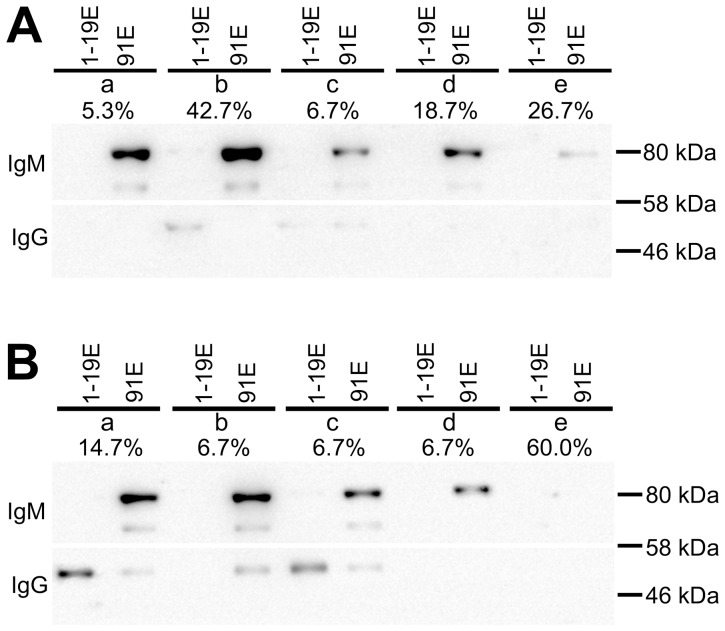
Western blot for IgG and IgM eluted from H31
–19 and H31–19K9me beads.Equal volumes (1.5 ml) of pooled sera were first absorbed with the H31–19 beads and then with the H31–19K9me beads as described in the Materials and Methods. The beads were washed 5 times with 1 M NaCl, and the bound Abs were eluted with 50 µl elution buffer. 10 µl of the eluates underwent SDS-PAGE under reducing conditions and were then transferred onto nitrocellulose membranes. The membranes were cut at the 58 kDa position. IgG on the low molecular weight (<58 kDa) membrane and IgM on the high molecular weight (>58 kDa) membrane were detected. (A) Healthy adult samples; (B) aSLE patient samples. a, IgG(1–19high91x)IgM(1–19x91x); b, IgG(1–19low91low)IgM(1–19high91high); c, IgG(1–19low91low)IgM(1–19high91low); d, IgG(1–19low91low)IgM(1–19low91high); e, IgG(1–19low91low)IgM(1–19low91low). 1–19E, Abs eluted from the H31–19 beads; 91E, Abs eluted from the H31–19K9me beads. The percentages represent the sample proportion of each subgroup (see Table 1). The results are representative of two independent experiments.